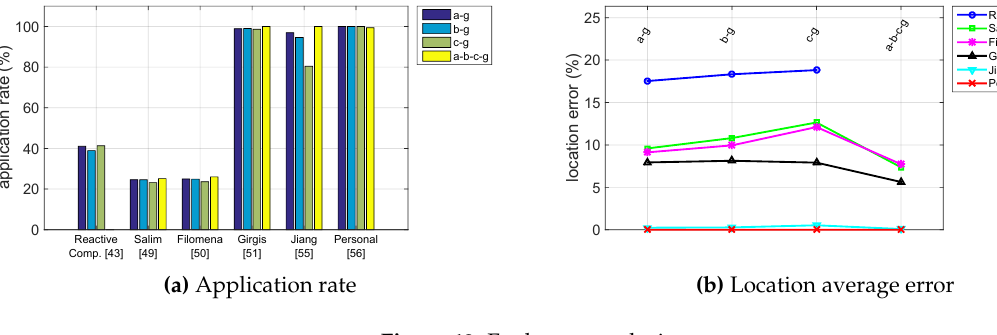
Figure 12. Fault type analysis.